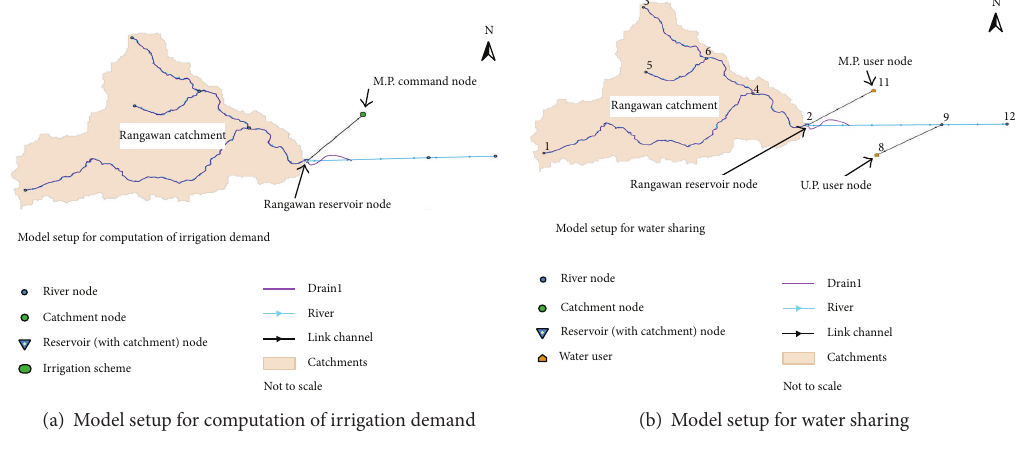
Figure 3: MIKE BASIN model setup of the Rangawan reservoir for computation of different scenarios.